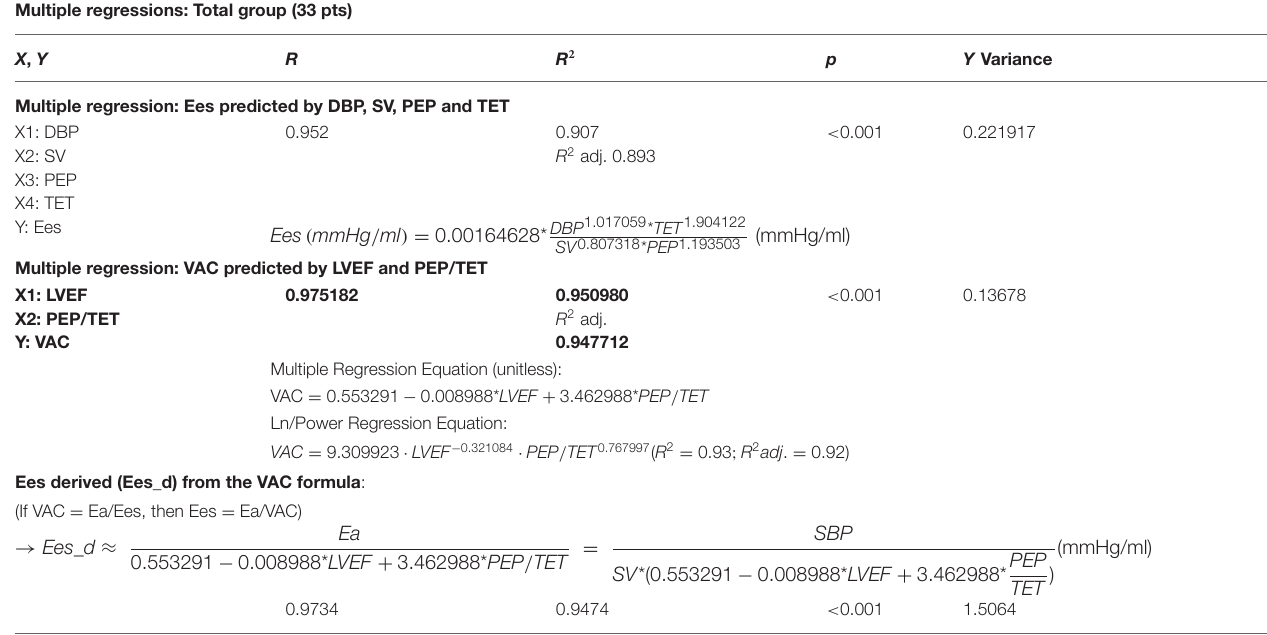
TABLE 4 | Multiple regressions for Ees and VAC prediction. Multiple regressions: Total group (33 pts)